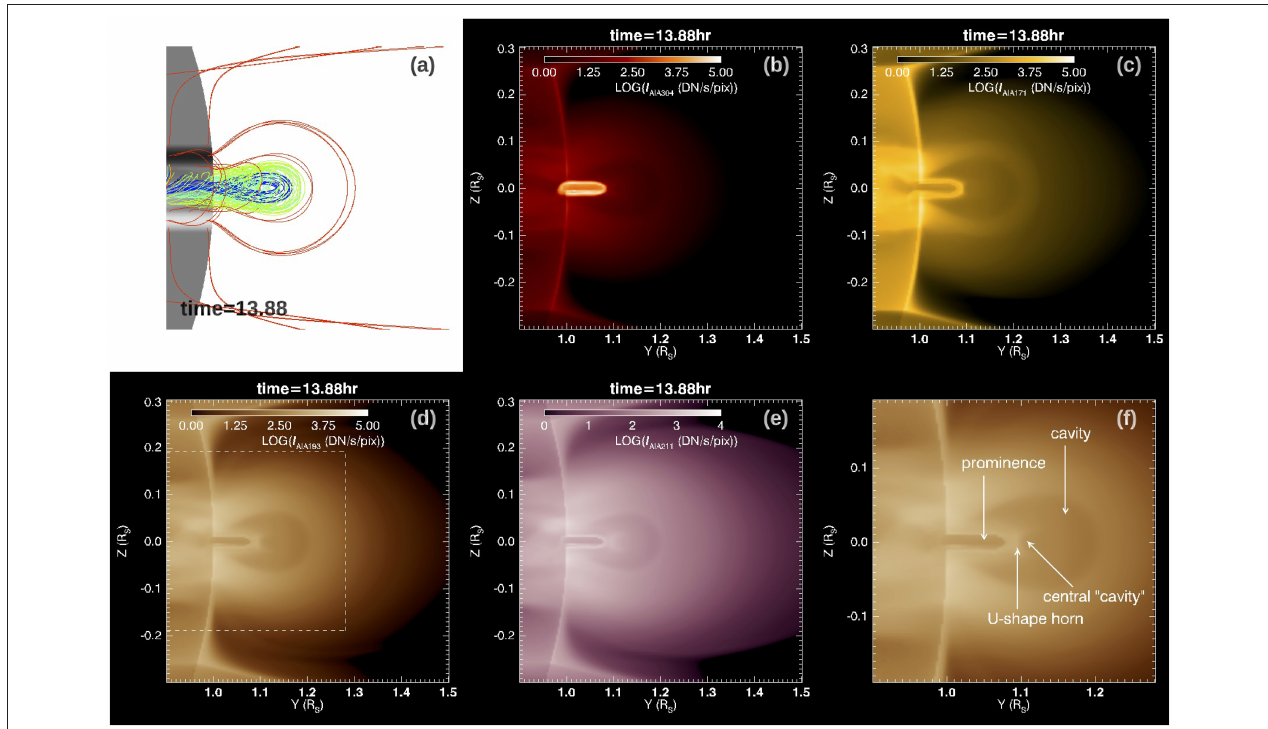
FIGURE 7 | 3D field lines (a) , and synthetic SDO/AIA EUV images in 304 Å (b) , 171 Å (c) , 193 Å (d) , and 211 Å (e) channels, with the flux rope viewed along its axis above the limb, at time t = 13.88hr during the quasi-static phase. (f) shows the zoomed in view of the boxed area of (d) with the cavity substructures